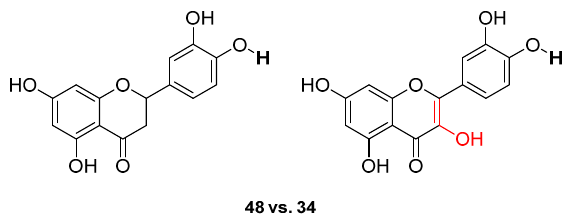
Figure 11. Comparison between flavanones ( 48 ) and flavonols ( 34 ).